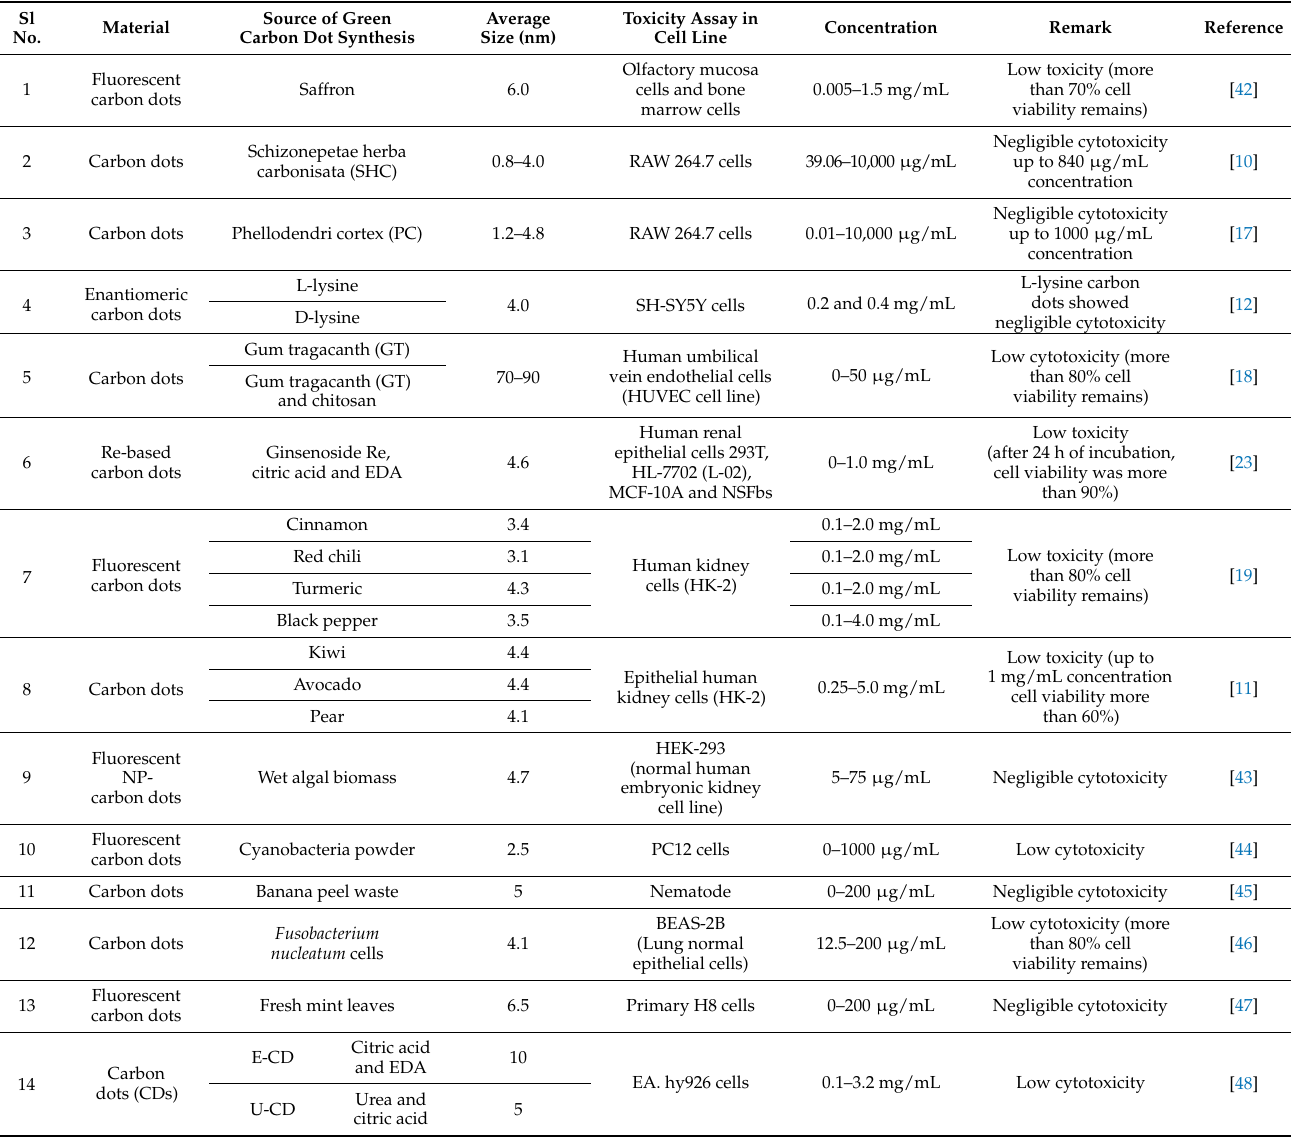
Table 9. Toxicity of GCDs for normal